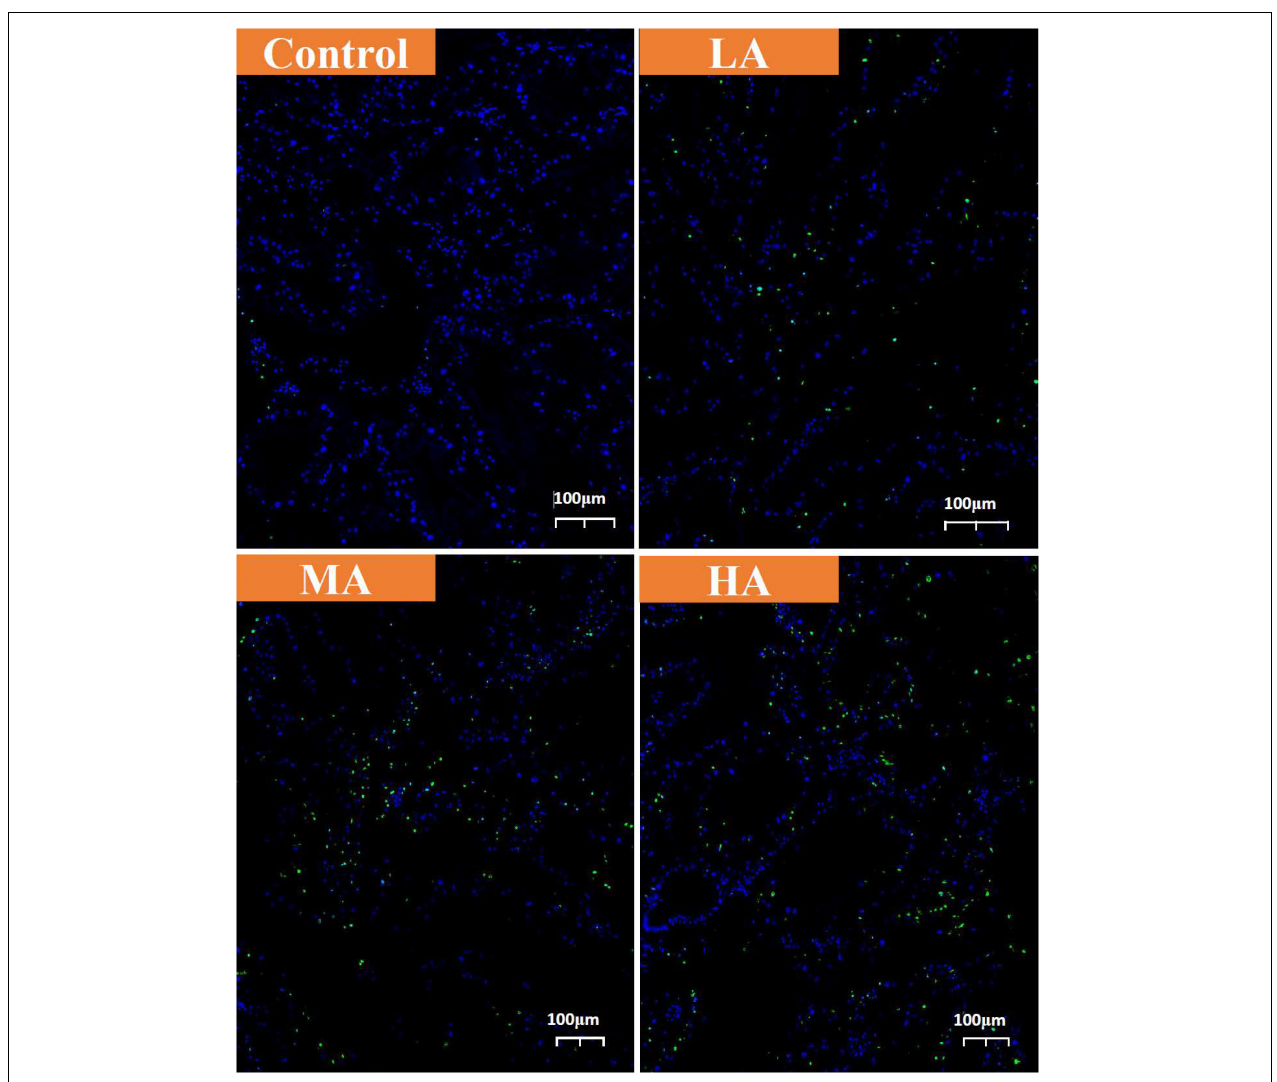
FIGURE 8 | TUNEL assay of hepatopancreas from control, LA, MA, and HA groups. The apoptotic cells were detected by TUNEL (green) and the nuclei were detected by DAPI